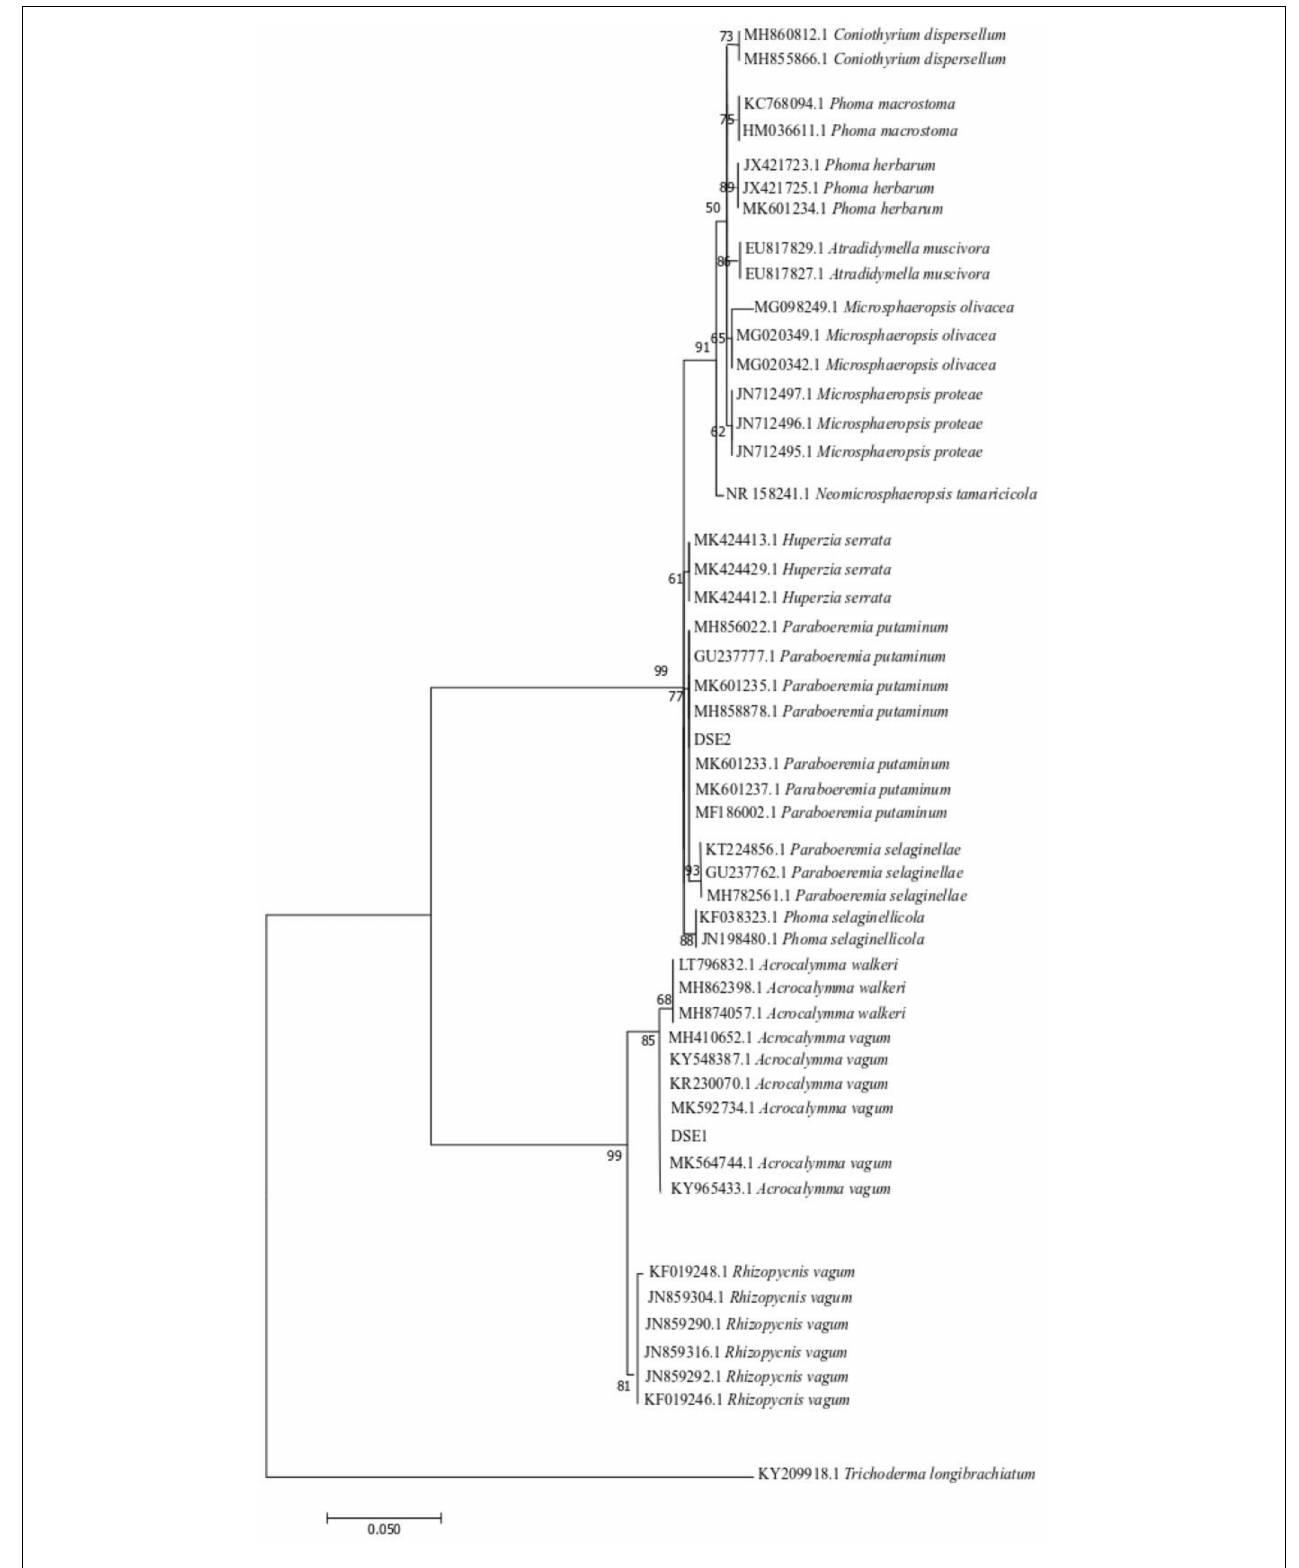
FIGURE 2 | Maximum parsimony tree generated from ITS (ITS4 and ITS5) sequences of the isolate strains and their closest matches, followed by GenBank accession number.